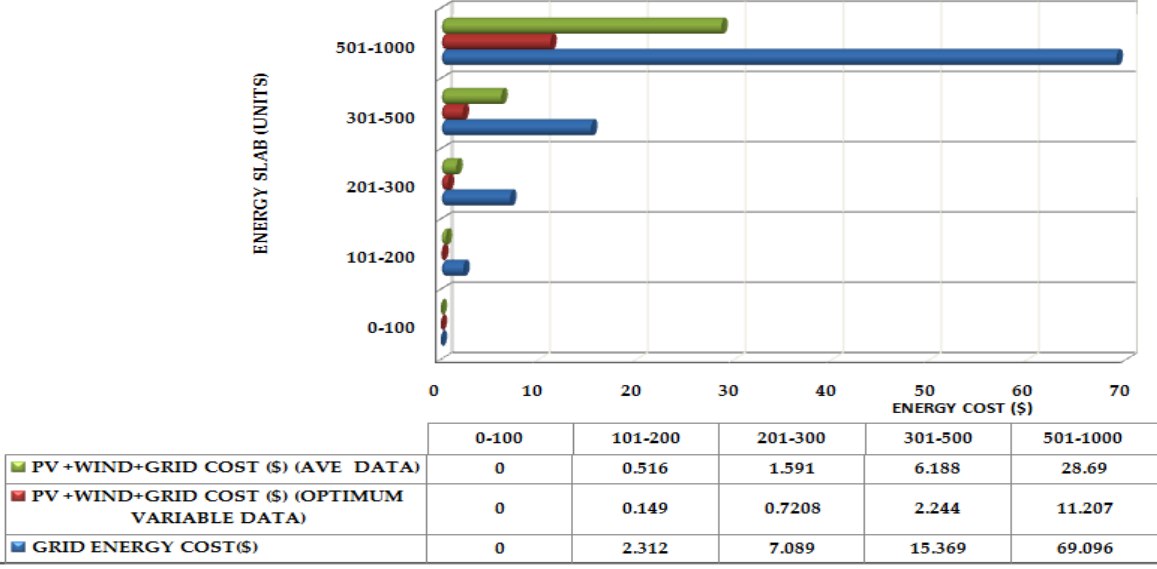
Figure 23. Electrical tariff-based cost-saving for different combinations of energy mixing.